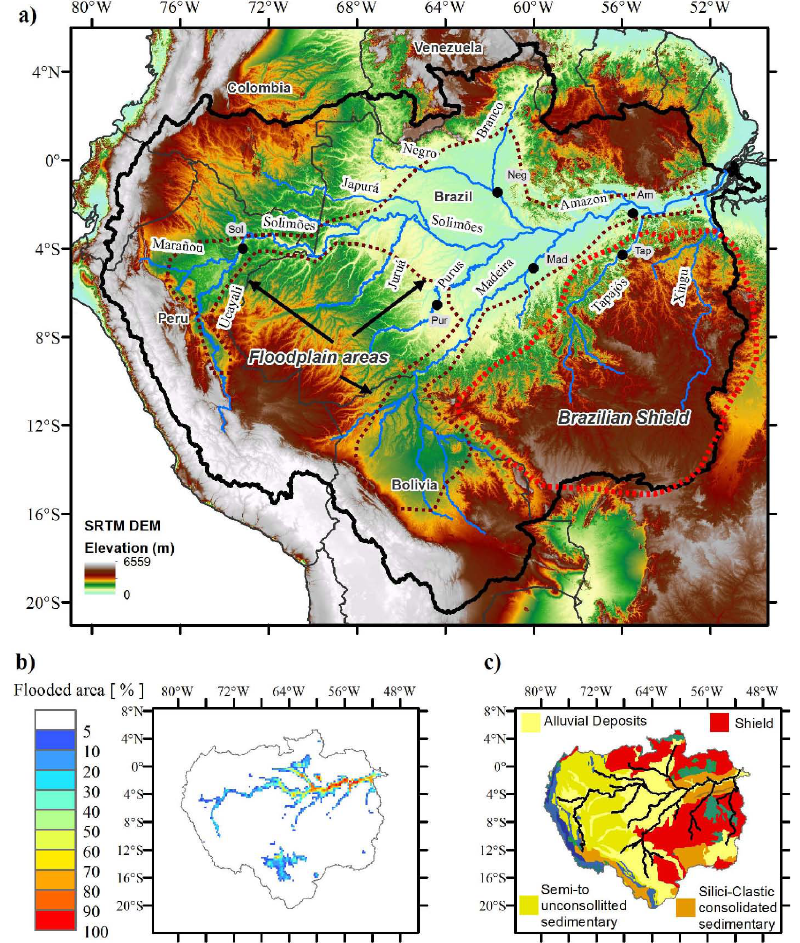
Fig. 1. (a) Amazon River basin with main tributaries, international limits, relief from SRTM DEM (Farr et al., 2007) and sites used in analyses (black circles), (b) mean flooded area (%) derived from Papa et al. (2010) and (c) Lithological map derived from Durr et al.